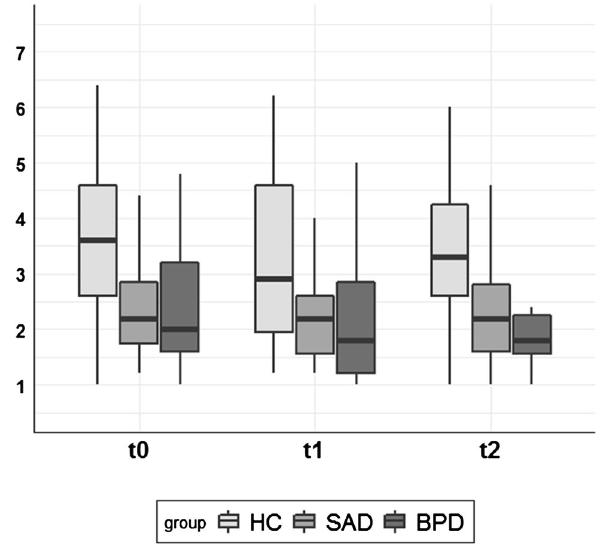
Figure 2. Box plots of positive emotions (range 0–7) for each group before the Cyberball game (t0), after the inclusion condition (t1) and after the overinclusion condition (t2). Boxes range from first to third quartile and represent the middle 50% of the data. Whiskers represent minimum and maximum scores. HC healthy controls, BPD borderline personality disorder, SAD social anxiety disorder.